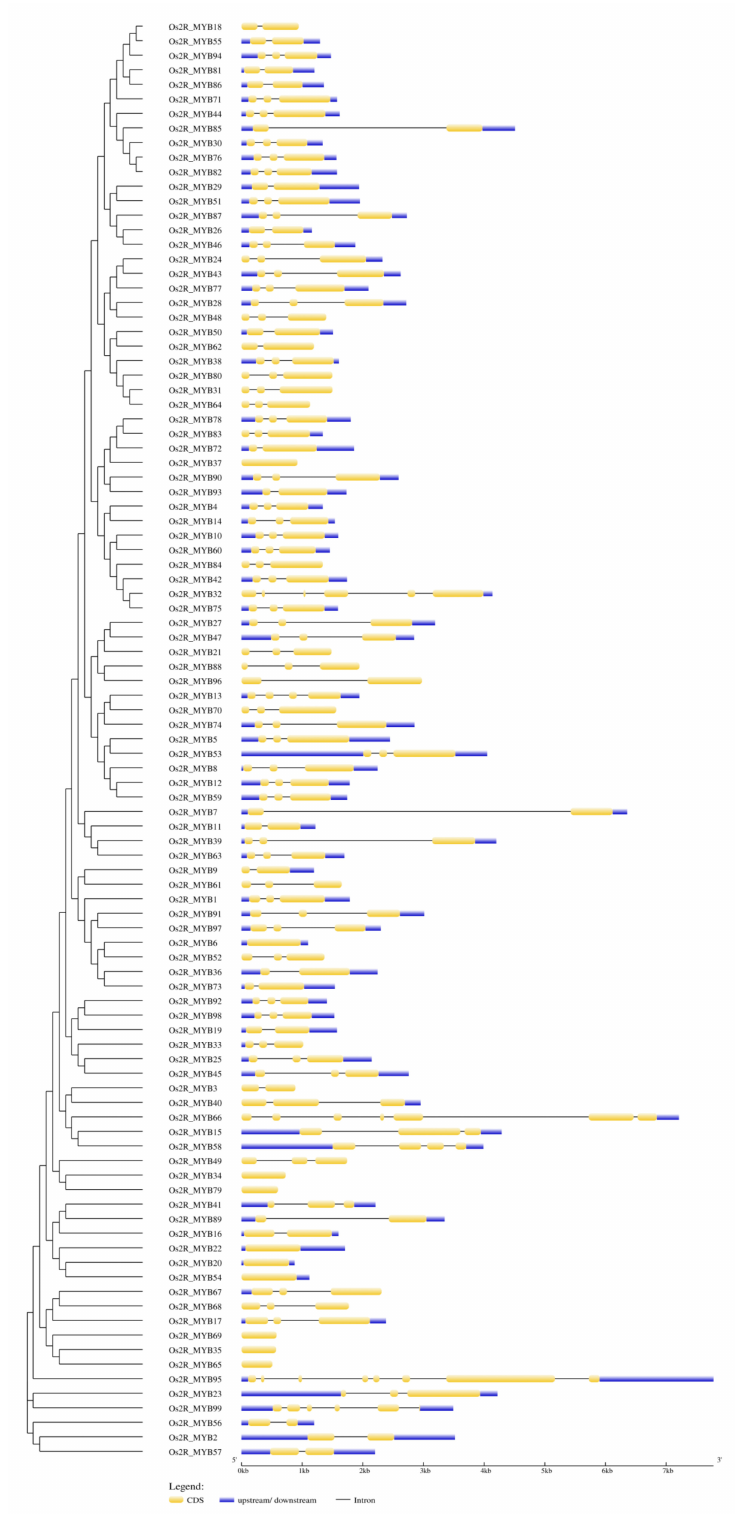
Figure 3. Phylogenetic tree and intron/exon structure of Os2R_MYB genes. The blue boxes represent the 5 (cid:48) or 3 (cid:48) untranslated regions (UTR), the yellow boxes represent the coding sequences (CDS), and the black lines represent the intron